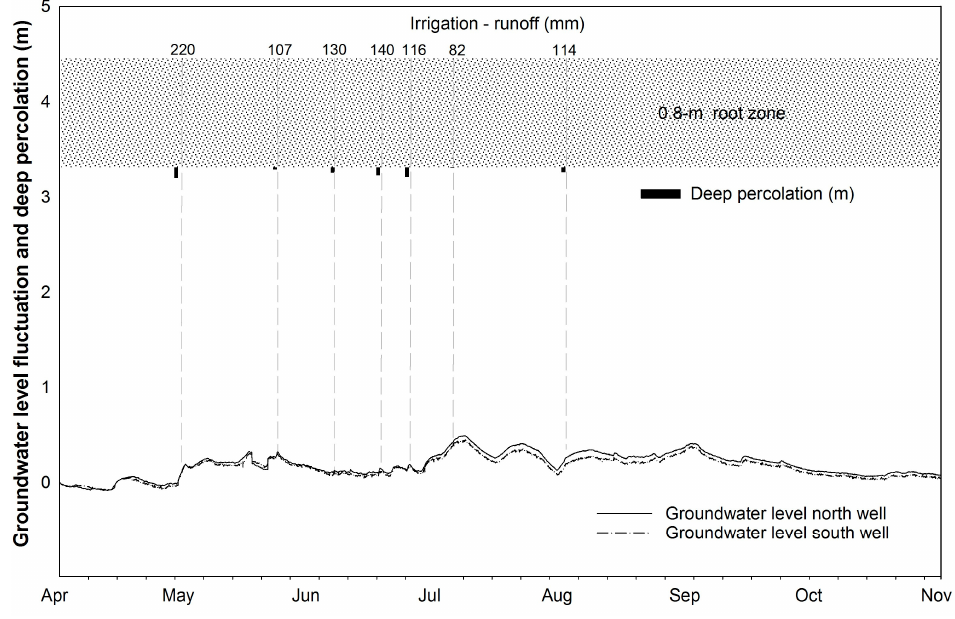
Figure 6. Irrigation water application, deep percolation, and shallow groundwater level fluctuations observed at the Alcalde study site.